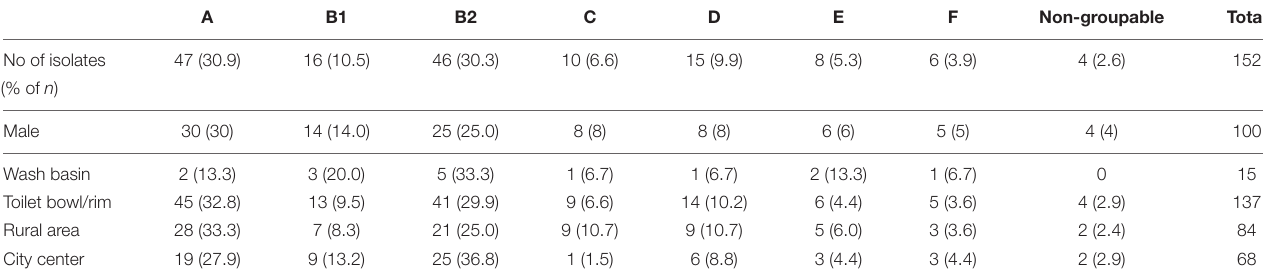
TABLE 3 | The distribution of phylogenetic groups in 152 E. coli isolates found in public restrooms.